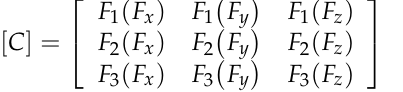
Figure 5. Calibration plot for system with necked collars. 4. Static Loading Experiment For the validation of the calibration process, the calibrated tri-directional force meas- urement system was appropriately loaded in three orthogonal directions simultaneously using the wire-pulley setups as seen in Figure 6. Several load cases consisting of different load combinations along x, y and z axis ( 𝐹 𝑥 , 𝐹 𝑦 and 𝐹 𝑧 ) were applied and the output force values read by sensors ( 𝐹 1 , 𝐹 2 and 𝐹 3 ) were logged for each set of simultaneously applied loads. The calibrated tri directional force measurement system was zeroed before com- mencing the load cases to eliminate the possibility of any offset errors.